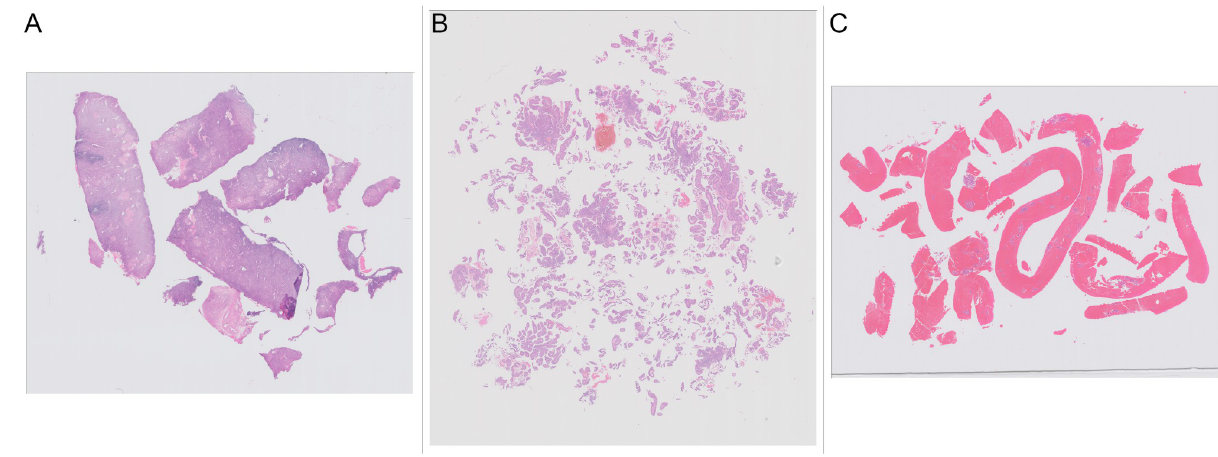
Fig 1. Examples of slides with different amounts and presentation of tissue. (A) Slide with a few large pieces of tissue. (B) Slide with many small fragments of tissue. (C) Slide with large amounts of blood clot.